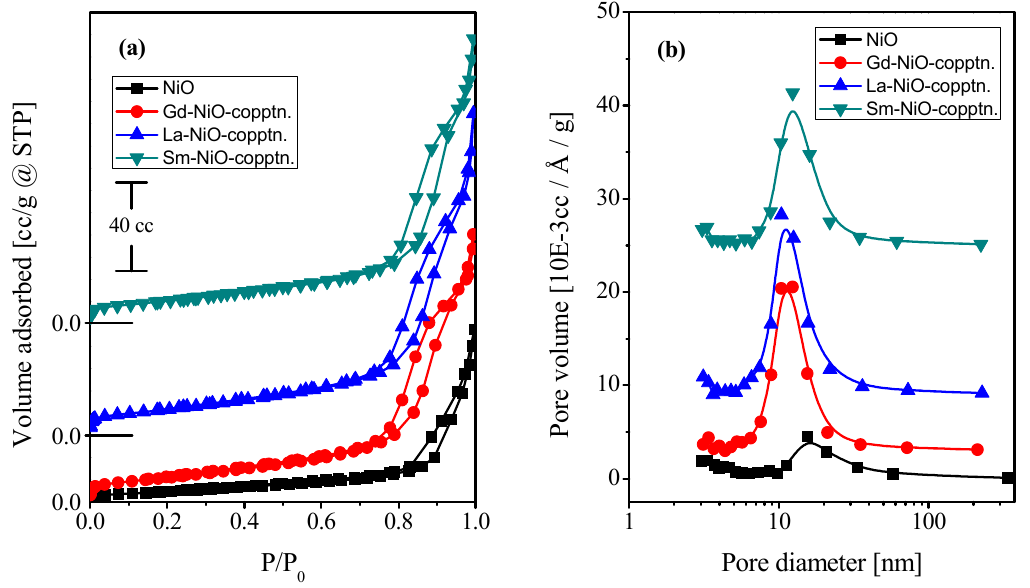
Figure 6. Nitrogen adsorption isotherms ( a ) and pore size distribution curves ( b ) of the calcined NiO, Gd/NiO, La/NiO and Sm/NiO catalysts.